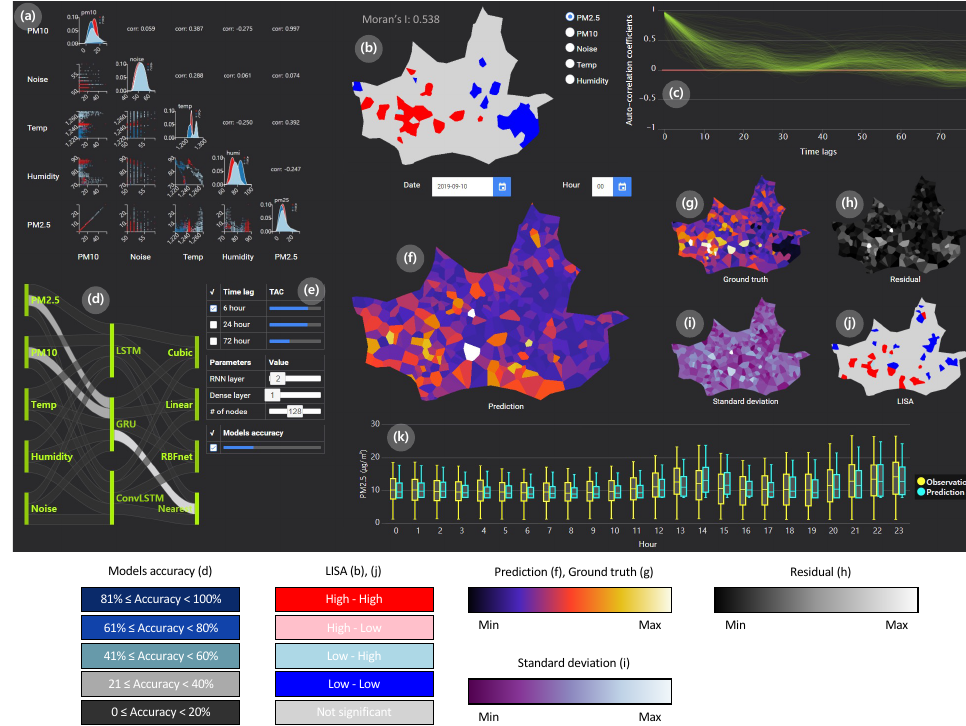
Figure 1. Our visualization system for analyzing deep learning models. ( a ) is the scatterplot of the correlation and probability distribution between input variables. ( b ) shows spatial autocorrela- tion (Moran’s I) of the selected variable. ( c ) presents line density map with temporal autocorrelation. The Sankey diagram supports the modeling of the spatiotemporal prediction by combining features, deep learning models, and interpolation models in ( d ). ( e ) presents our prediction modeling param- eter settings. ( f ) presents interpolated predictions with the nearest neighbor algorithm. ( g ) shows the observed data. ( h ) presents the errors between the observed data and predictions. ( i ) shows the standard deviation of prediction over time. ( j ) presents the LISA visualization. ( k ) The box plots show temporal predictions with the actual observed